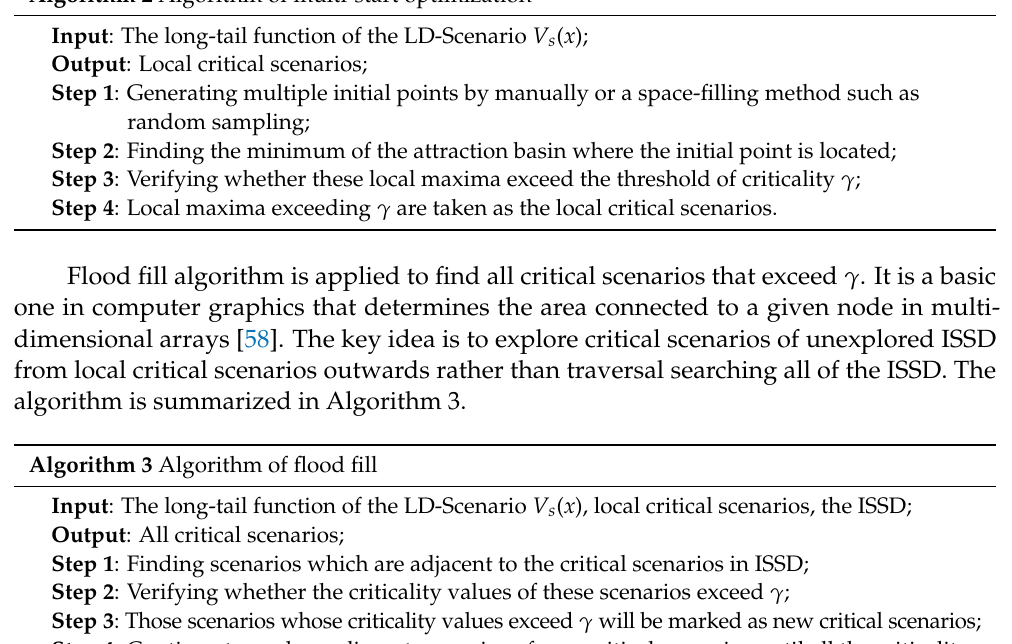
Algorithm 2 Algorithm of multi-start optimization